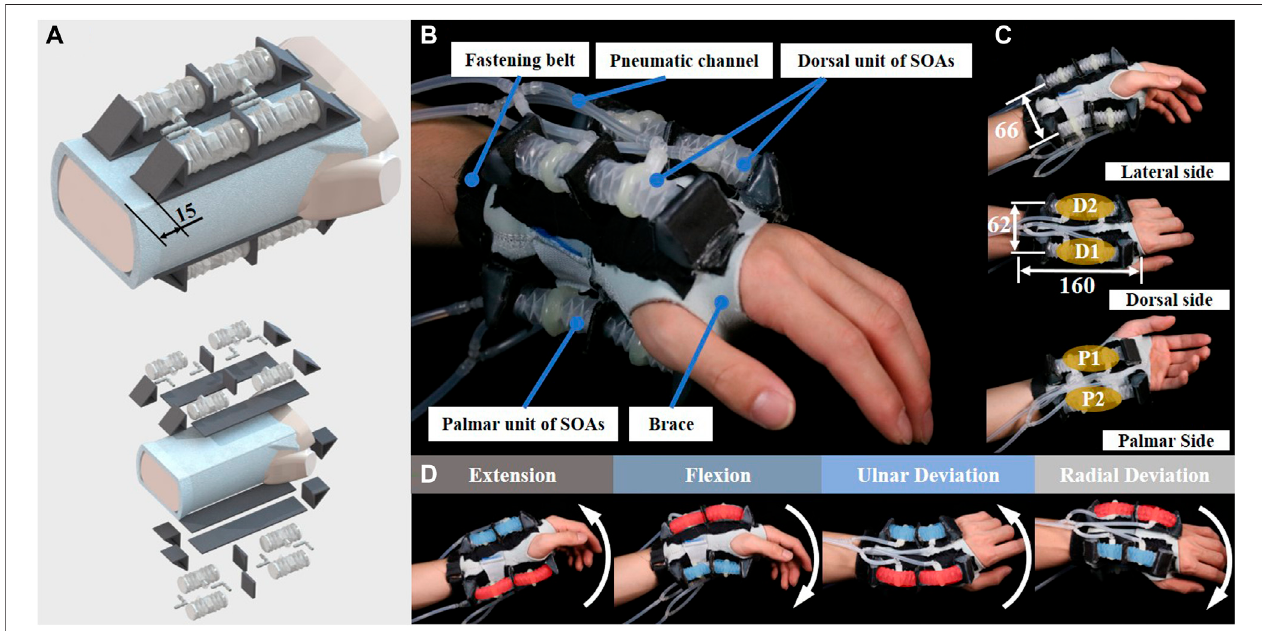
FIGURE4| DesignofSRbraceandtheprototype, (A) thesoftroboticbraceincorporateseightSOAsintofour2-SOAunitsatthepalmaranddistalsideofthewrist; (B) theSR brace prototype worn on human wrist; (C) the dimensions ofthebrace; (D) the brace moved thehumanwristin fl exion, extension, ulnar, and radial deviation.